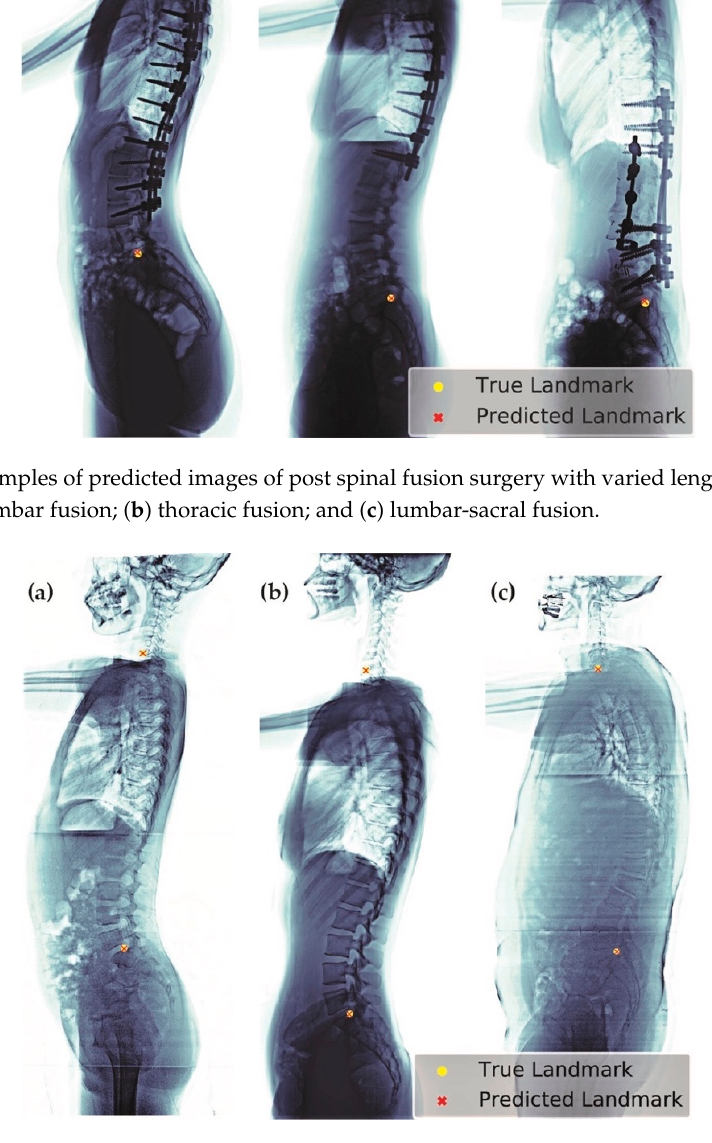
Figure 11. Examples of predicted images of different clinical conditions. These images include patients of: ( a ) ages 8; ( b ) age 23; and ( c ) age 63, who also present with degenerative change.